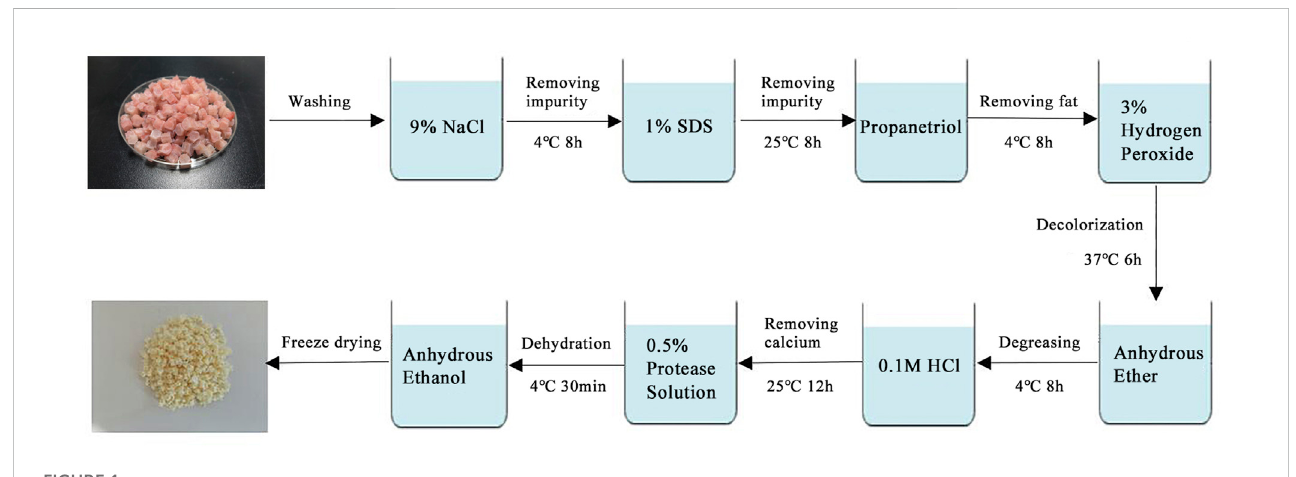
FIGURE 1 Preparation of fi sh decalci fi ed bone matrix